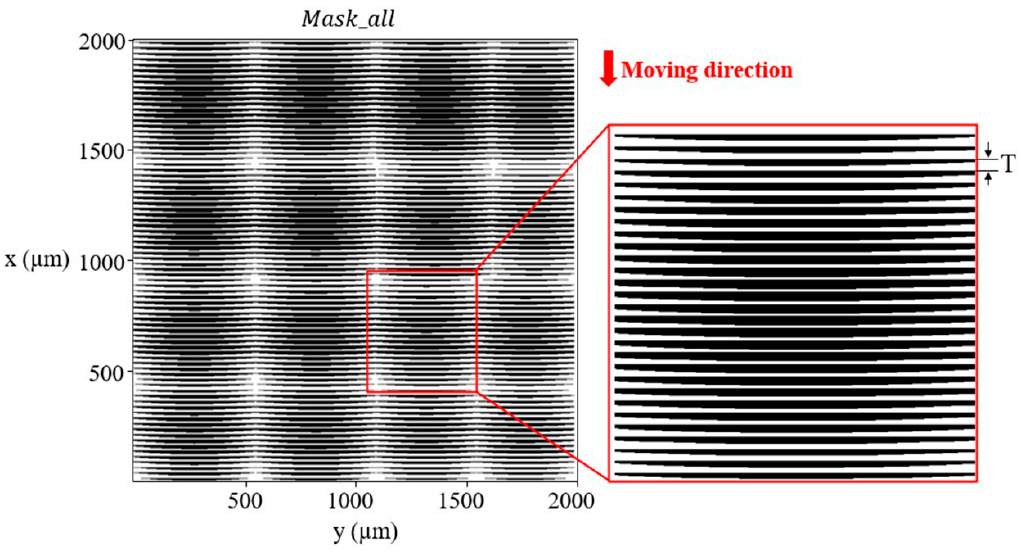
Figure 4. Mask pattern.